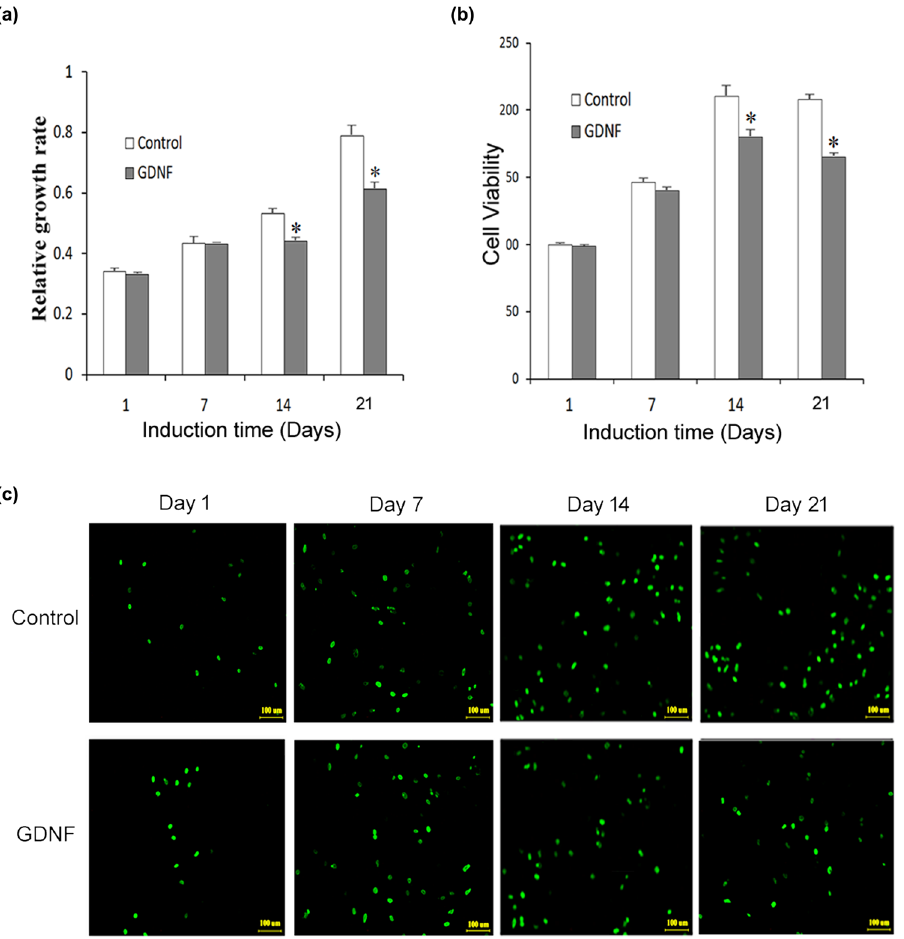
Figure 1: E ff ect of GDNF on BMSC viability and proliferation. ( a ) The OD values of bone marrow stromal stem cells were measured by CCK - 8 after GDNF induction. ( b ) E ff ect of GDNF induction on cell viability of bone marrow stromal stem cells was determined by the MTT assay. ( c ) FITC - conjugated Brdu ( green ) immuno fl uorescent staining. Bar = 100 µm. * p < 0.05 vs control